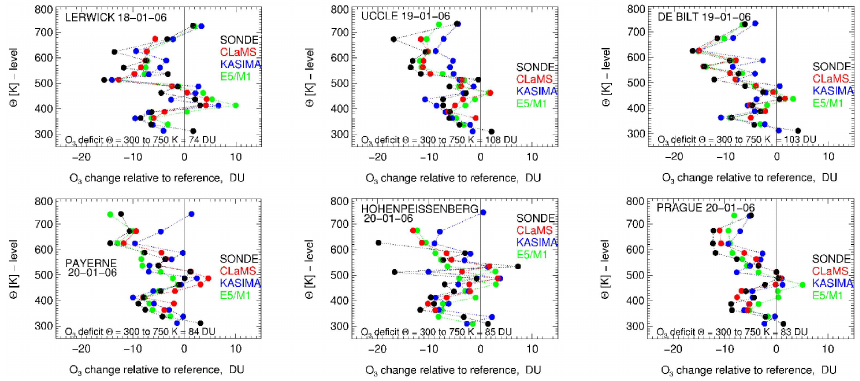
Fig. 14. Calculated ozone change in DU relative to the reference profiles, for observed (black points) and simulated (CLaMS = red, KASIMA = blue, E5/M1 = green points) ozone profiles at the six stations and the days of observed minimum total ozone; dotted lines for guiding the eye; negative values correspond to lower (reduction), positive values to higher (gain) values than the reference; values integrated between certain Theta-level intervals (details see